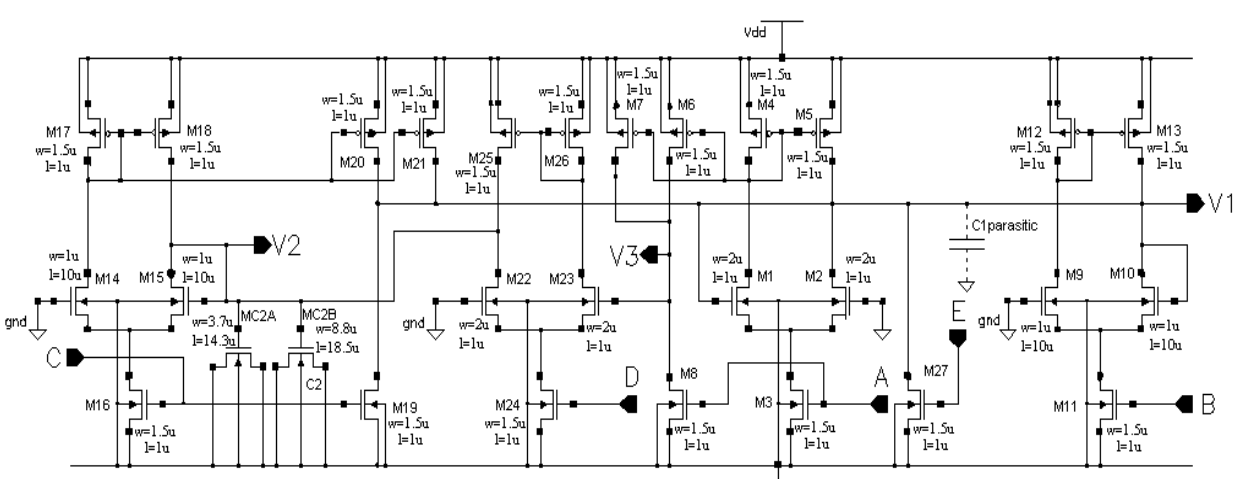
Figure 4. Schema of the oscillator